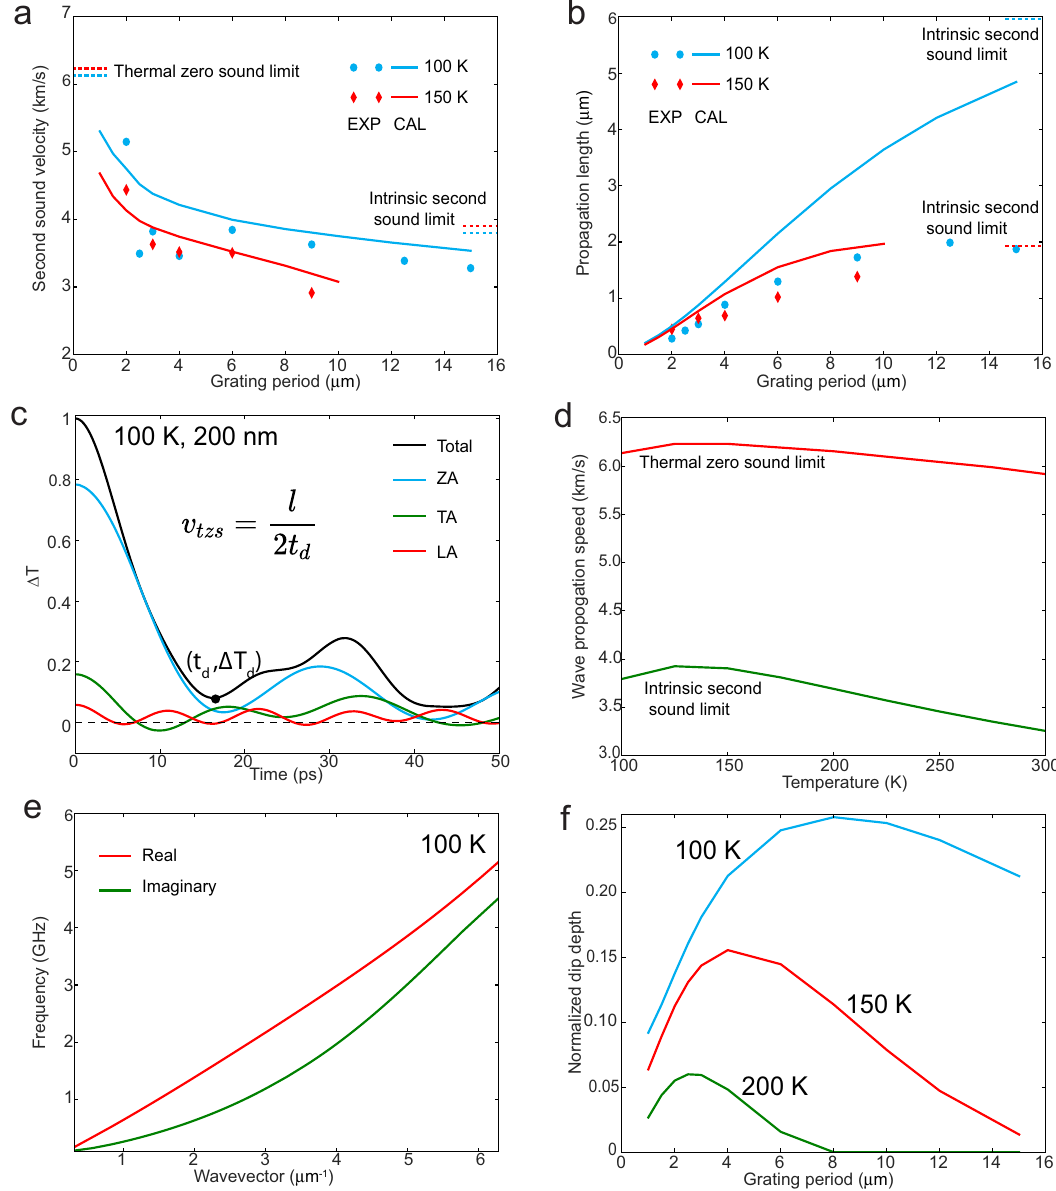
Fig. 2 Dispersion of thermal waves. The measured and calculated data are represented by points and curves, respectively. a Dependence of wave velocity on grating period. Also shown are the intrinsic second sound limit from Eq. (2) and the thermal zero sound limit discussed in Methods. Damping reduces the second sound velocity below the intrinsic limit at large grating periods, while zero sound increases the measured wave velocity at small grating periods. b Propagation length variation with grating period at different temperatures. c Calculated ballistic limit of the TTG signal at 100 K and its contributions from fl exural, longitudinal, and transverse acoustic modes (ZA, LA, and TA respectively). d Variation of the calculated ballistic and intrinsic second sound limits with temperature. e Dispersion of second sound at 100 K. f Variation of the calculated normalized dip depth with grating period at 100 K, 150 K, and 200